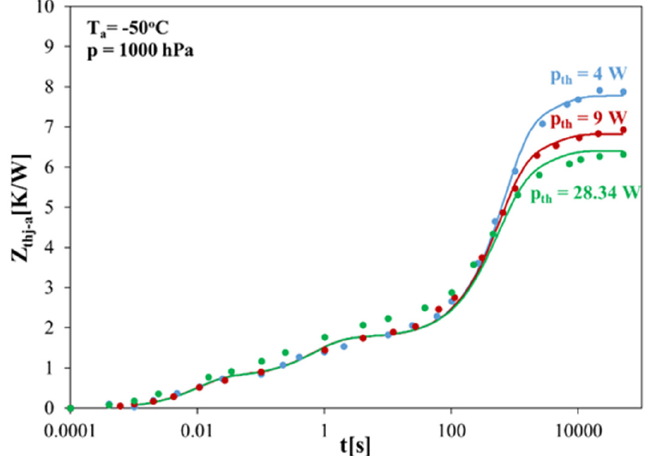
Figure 4. Measured and computed waveforms of transient thermal impedance of the tested diode for three values of dissipated power.